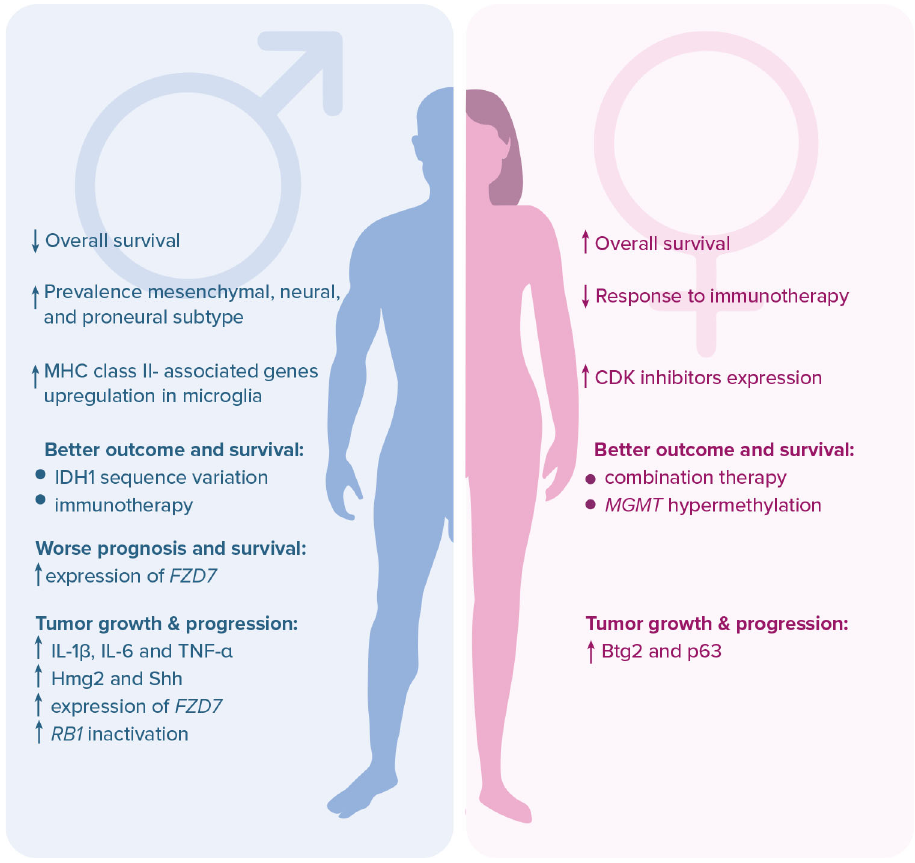
Figure 1. Major sex-dependent differences affecting therapeutic outcomes, prognosis, genetics, and immu- nology of glioblastoma patients. Legend: Btg2 – B cell translocation gene 2; CDK – cyclin-dependent kinase; FZD7 – frizzled class receptor; Hmg2 – high mobility group box 2; IDH1 – isocitrate dehydrogenase 1; IL – interleukin; MGMT – O6-methylguanine-DNAmethyltransferase;MHC – majorhistocompatibilitycomplex;p63 – transformation- related protein 63; RB1 – retinoblastoma protein 1; Shh – sonic hedgehog human; TNF- α – tumor necrosis factor alpha.